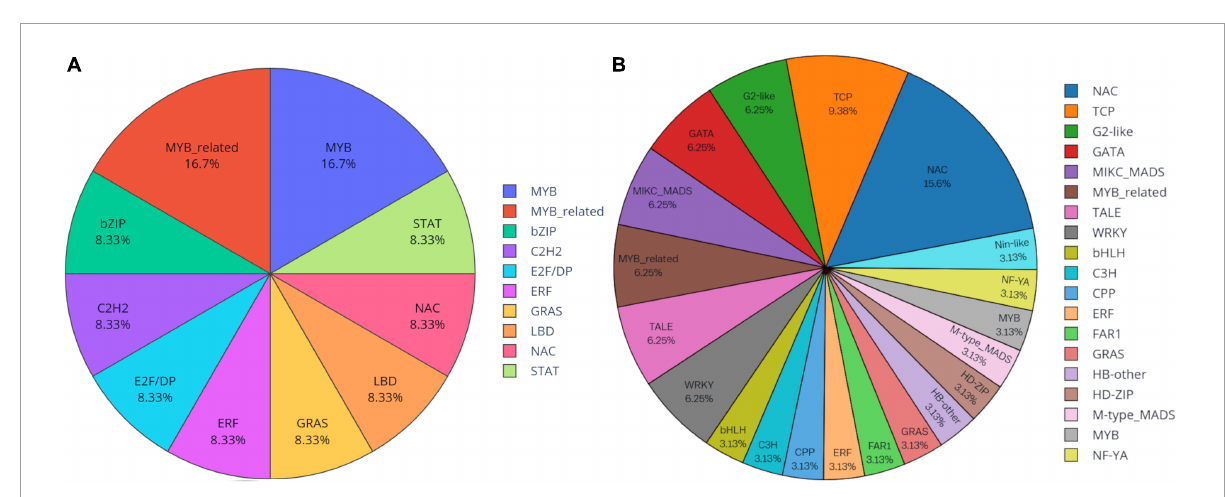
FIGURE8 Differentially expressed transcription factors (TFs) in (A) pseudobulb and (B) leaf tissues of M. acuminata